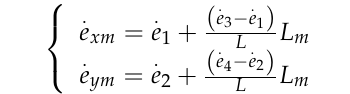
Figure 2. The piston eccentricity and radial movement of the section m.